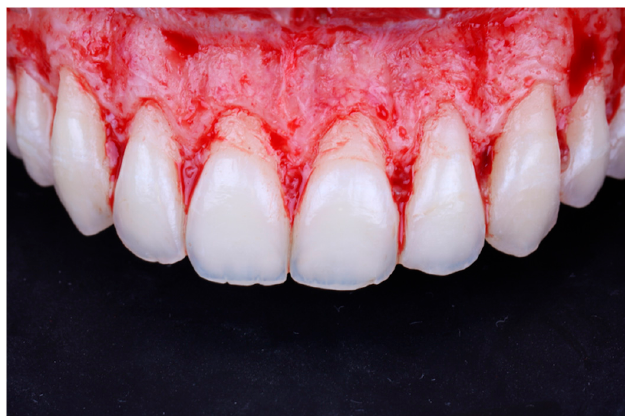
Figure 9. Bone level after osteoectomy and osteoplasty.